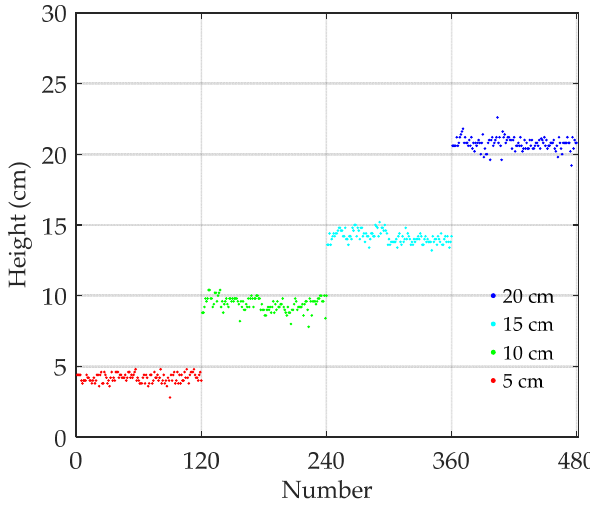
Figure 18. Recognition results with different void fillers.